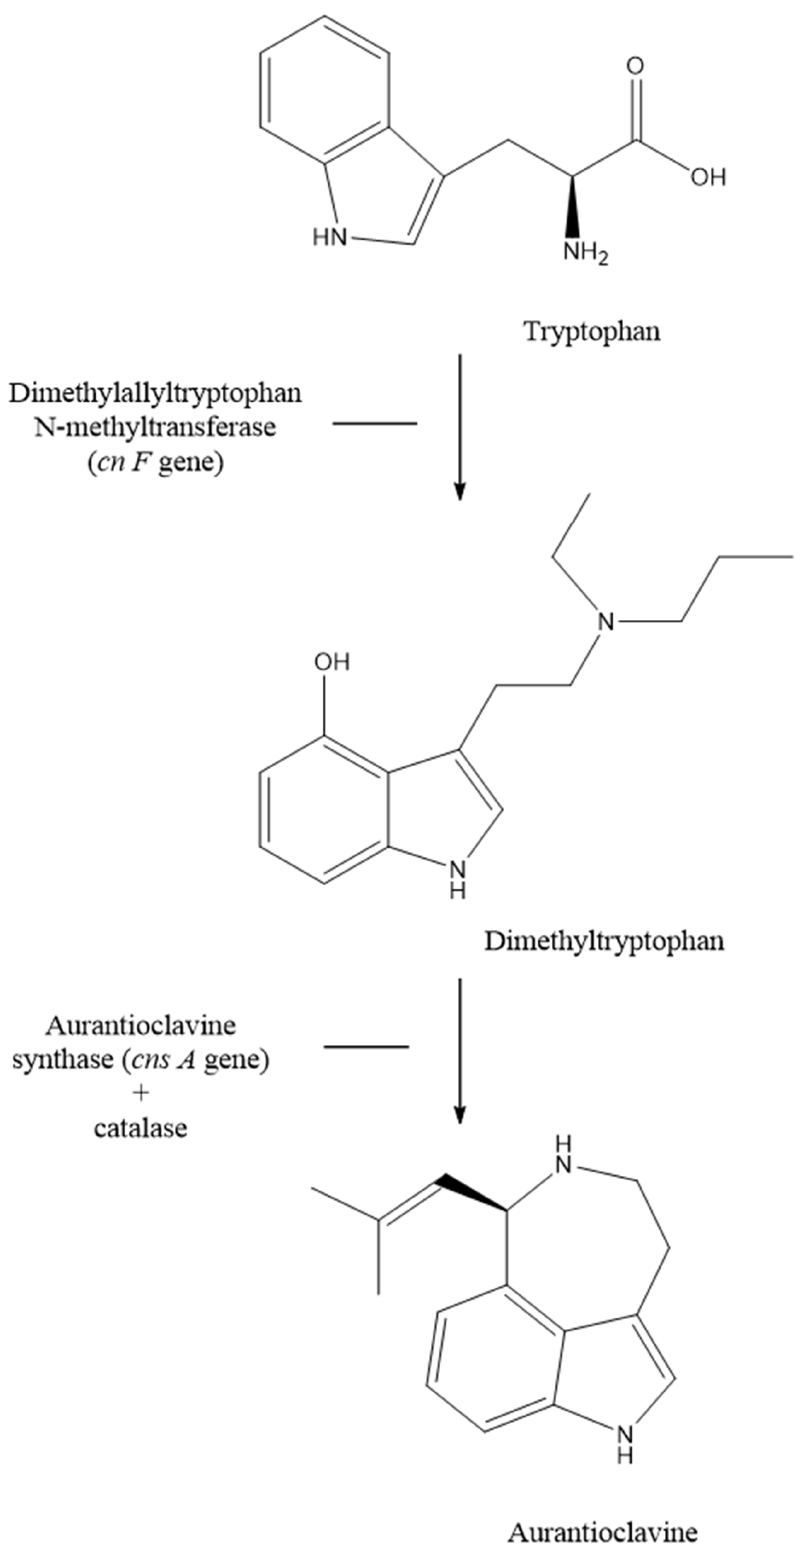
Figure 2. Summary of biosynthesis pathway of aurantioclavine found in Streptomyces sp. SUK 48, which was similar with biosynthesis pathway in Penicillium expansum .